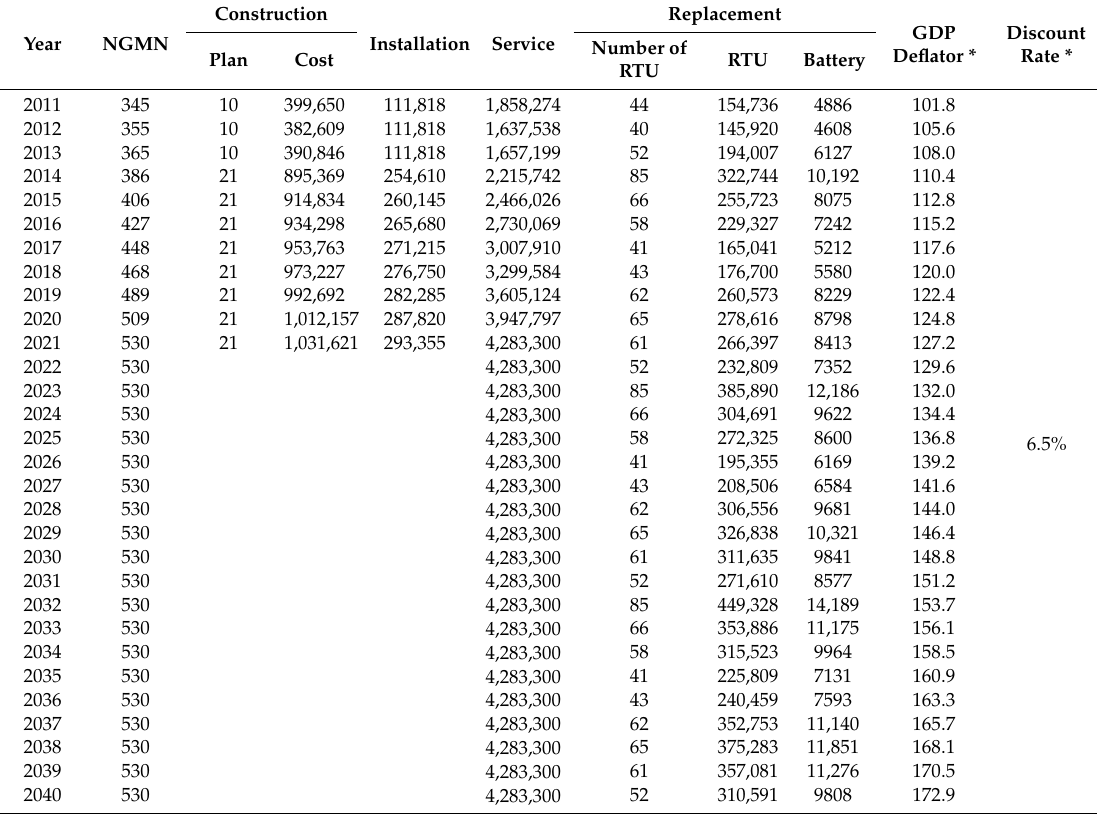
Table A1. Cost detail of the NGMN (unit: